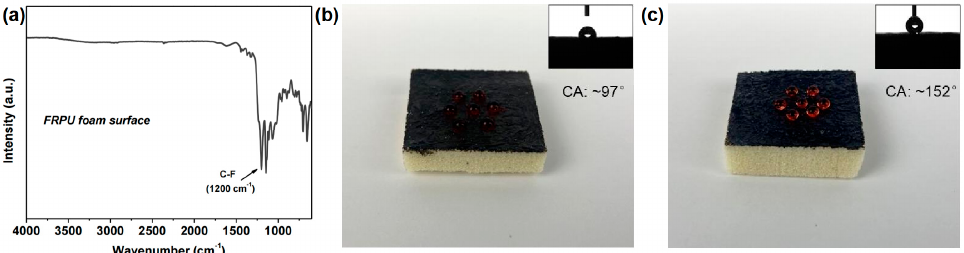
Figure 15. ( a ) IR spectra of hybrid flame-retardant coating on FRPU foam surface. Due to surface hydrophobic treatment, a strong peak at ~1200 cm − 1 can be observed, which is assigned to C-F; Digital and corresponding contact angles photos (inset) of FRPU samples ( b ) before and ( c ) after hydrophobic treatment [72].